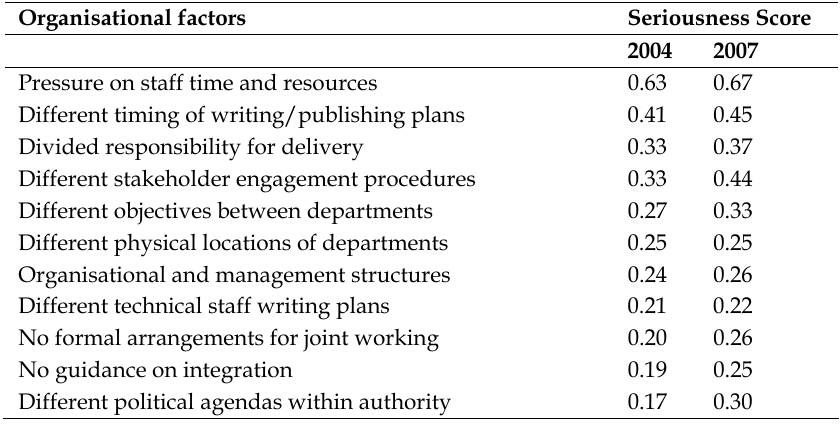
Table 6. Hindrances to Integrated Planning & Decision